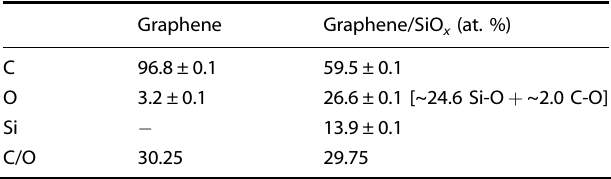
Table 2. Relative (%) atomic concentration of O, Si, and C and C/O ratio derived from the XPS